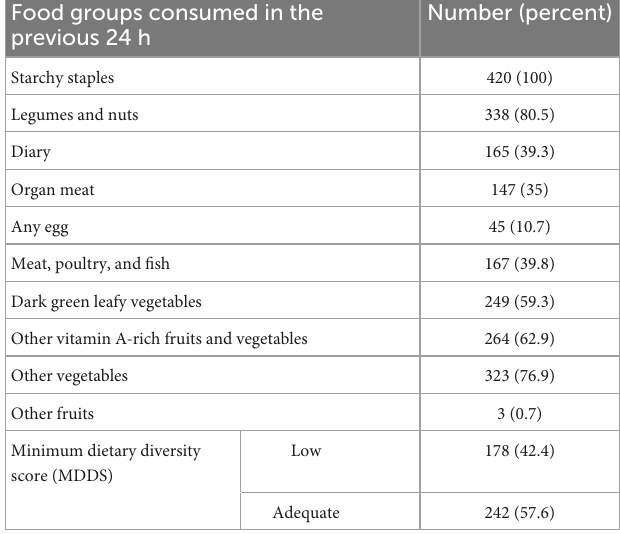
TABLE 2 Maternal reproductive and healthcare-related characteristics among lactating mothers in Sekota Internally Displaced Persons (IDP) camps, northern Ethiopia, 2022.